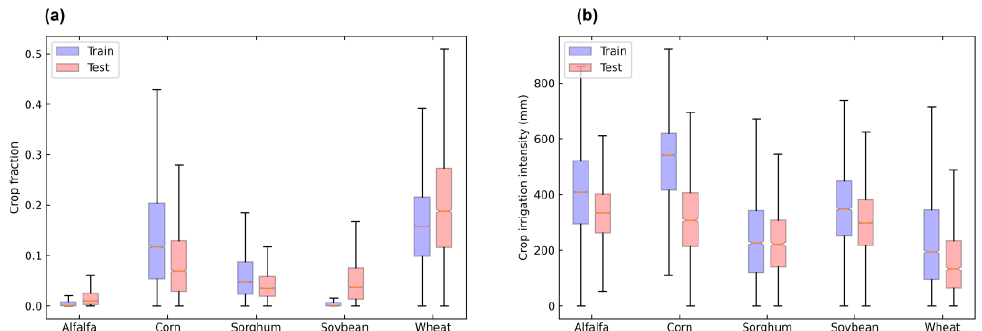
Figure 9. Boxplots of ( a ) crop fractions (the area of each crop in a grid divided by the total grid area) and ( b ) irrigation intensity of major crop types in Experiment B training and test regions, respectively, in Kansas HPA, averaged during 2006 – 2020.